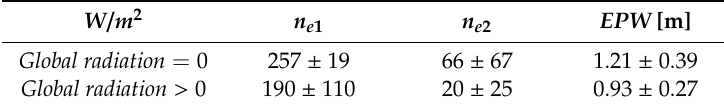
Table 2. Influence of background radiation on the total number of echoes and EPW for 1900 frames during the day and 1900 during the night including both regions during clear weather. The results show mean value ± standard